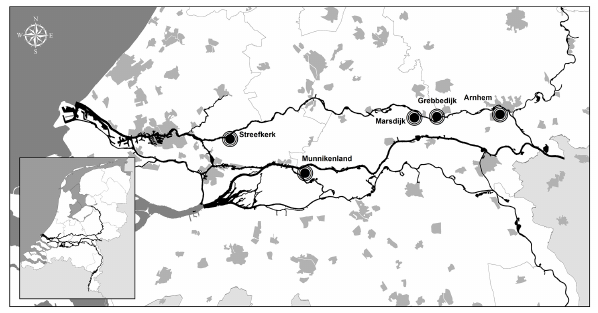
Fig. 4. Locations: (a) Streefkerk, (b) Marsdijk, (c) Arnhem, (d) Grebbedijk, and (e)